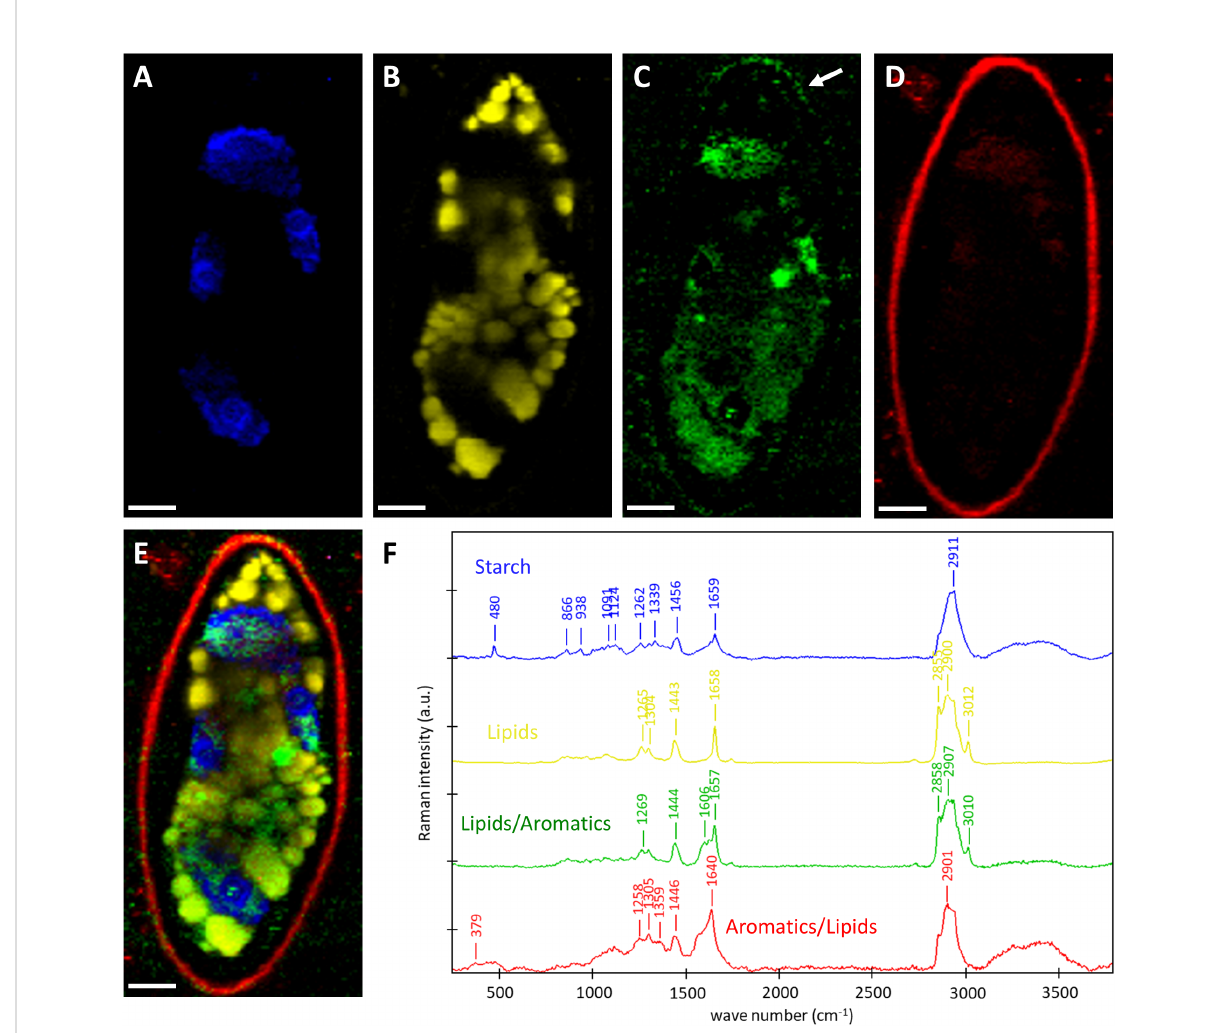
FIGURE 5 Raman imaging of Spirogyra sp. zygospore. (A – D) Distribution of the components found based on spectral characteristics of (A) starch; (B) lipids; (C) lipids/aromatics; (D) aromatics/lipids with distinct patterned appearance in the zygospore wall (arrow) and (E) merged image of the four components starch (blue), lipids (yellow), lipids/aromatics (green), and aromatics/lipids (red) and their (F) corresponding spectra with characteristic bands of the distinguished components. Scale bars 6